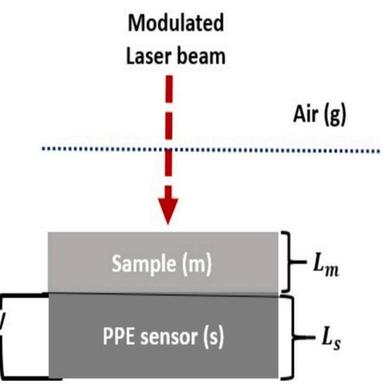
Scheme of the back configuration of the PEE experimental setup.